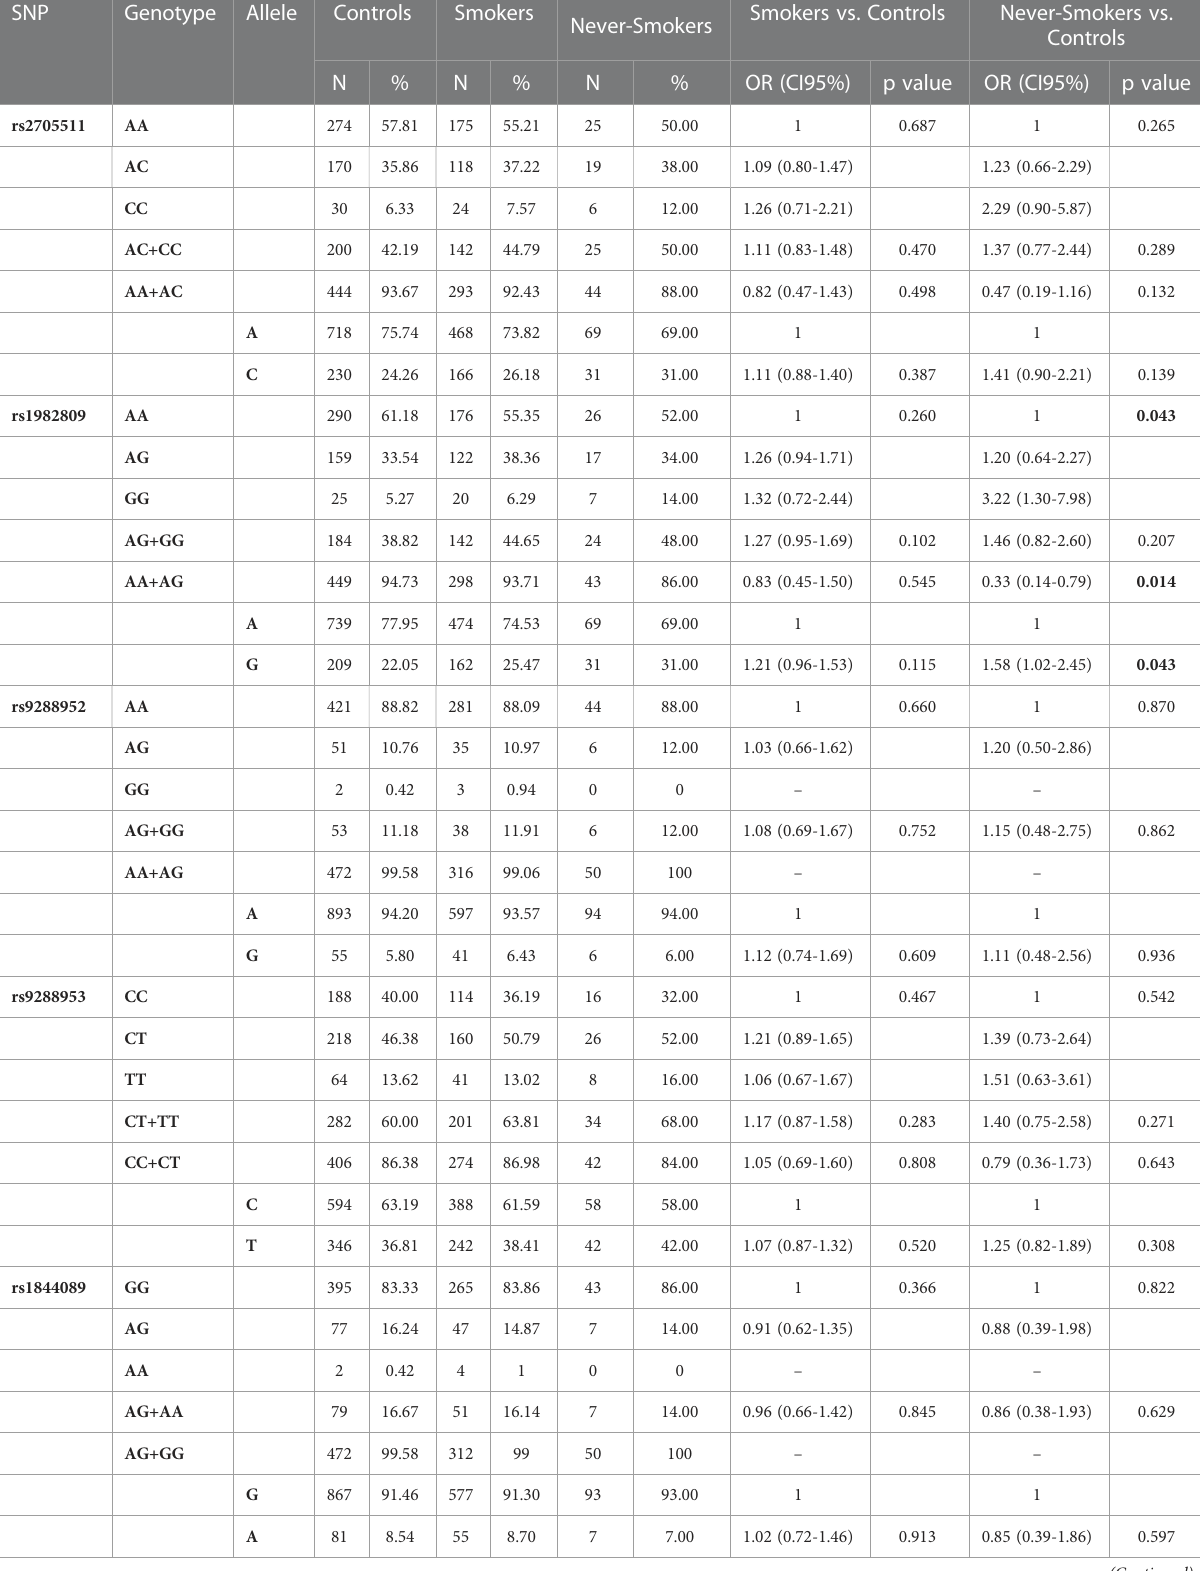
TABLE 5 Genotypes and alleles frequencies of BTLA SNPs and NSCLC risk in Smokers and Never-Smokers. SNP Genotype Allele Controls Smokers